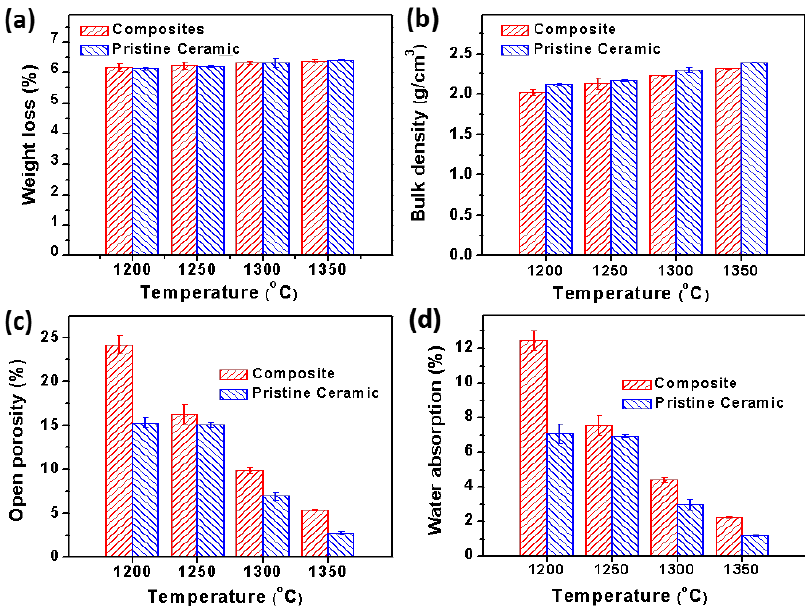
Figure 3. Physical properties of composites fired at different temperatures. ( a ) Weight loss, ( b ) bulk density, ( c ) open porosity, and ( d ) water absorption.